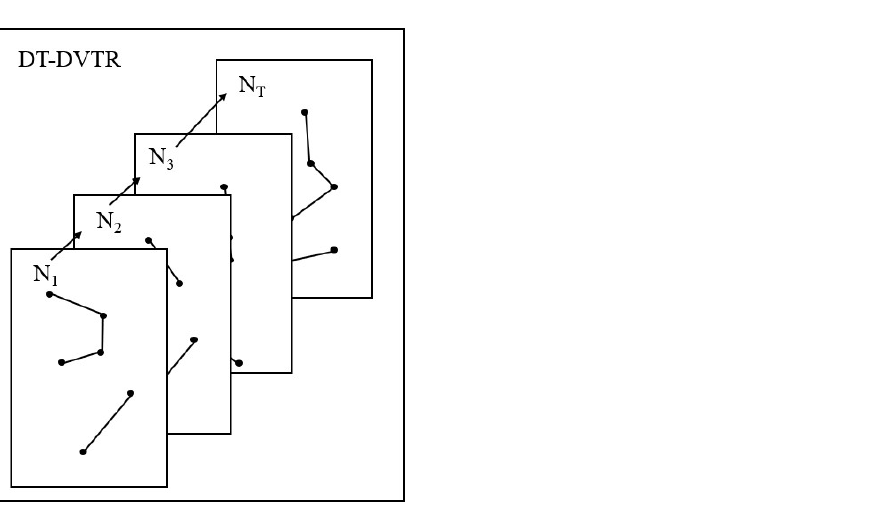
Figure 2. Key diagram of Discrete-Time Dynamic Virtual Topology Routing (DT-DVTR)